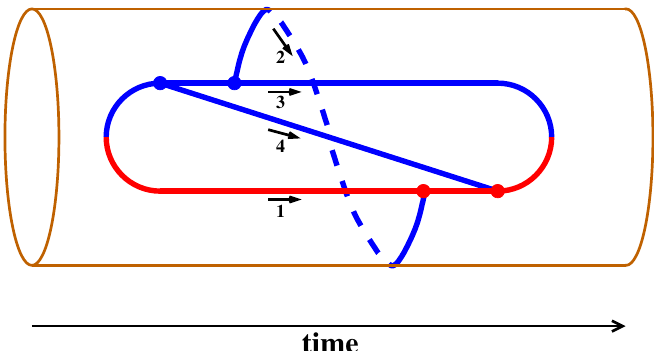
Figure 5 . Figure 3 drawn on a cylinder. Here, solid lines indicate lines drawn on the front of the cylinder, and dashed lines indicate lines wrapping around the